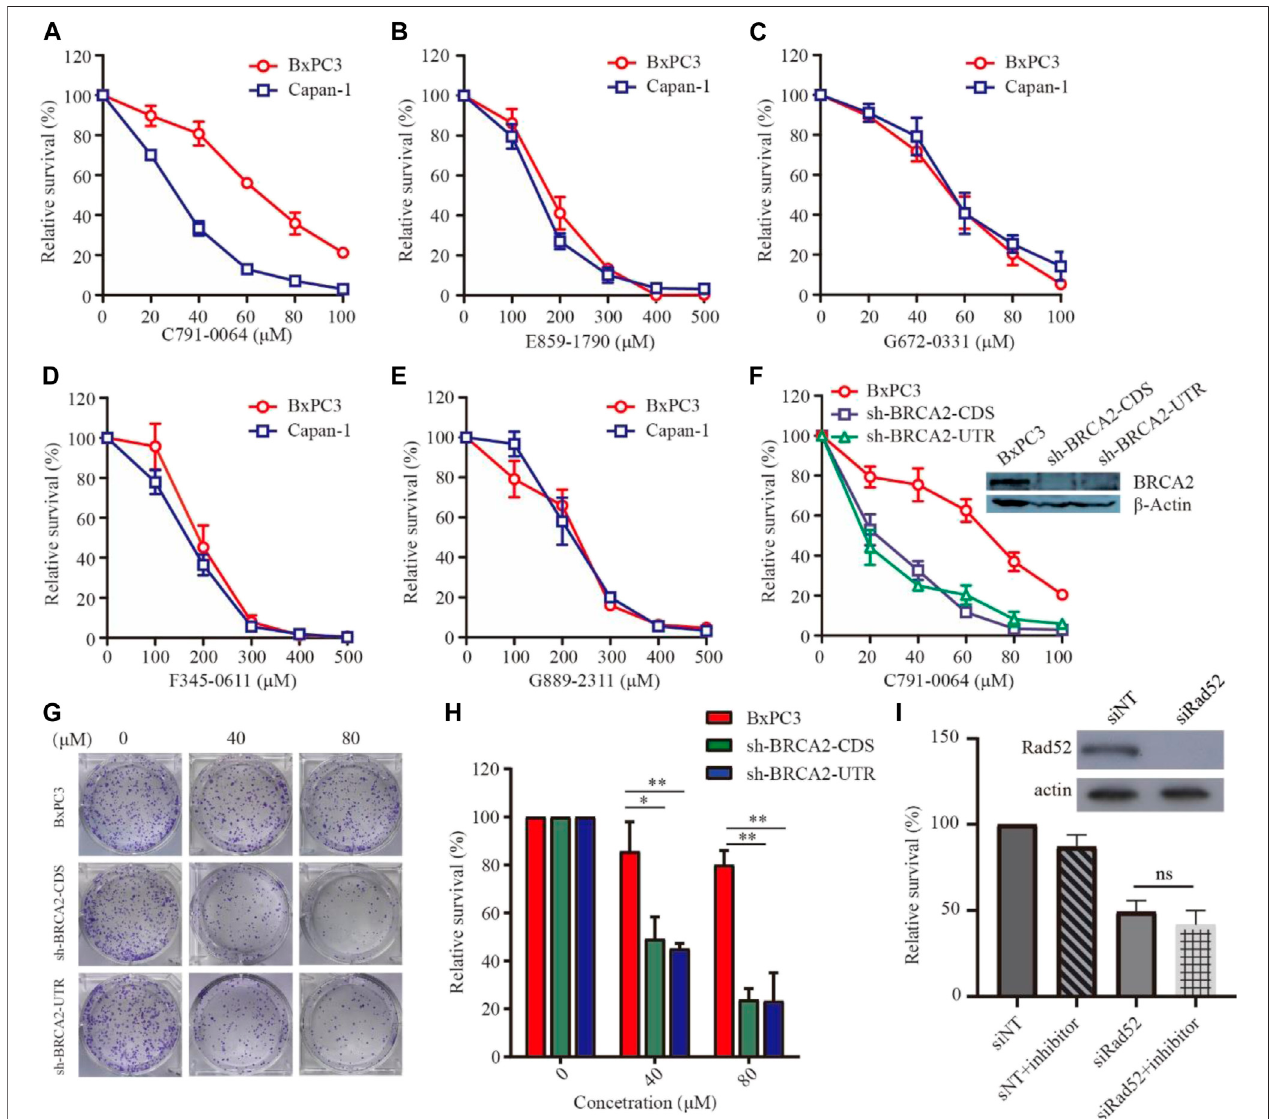
FIGURE3| EffectoftheputativeRAD52inhibitorsonthesurvivalofBRCA2wild-typeandde fi cientcells.Capan-1(BRCA2-de fi cient)andBxPC3(BRCA2wildtype) cellsweretreatedwithdifferentconcentrationsofthe fi vecompoundsfor72 h, (A) C791-0064, (B) E859-1790, (C) G672-0331, (D) F345-0611,and (E) G889-2311 (F) ( n (cid:2) 3). C791-0064 treatment of BRCA2-knockdown BxPC3 cells (sh-BRCA2-CDS and sh-BRCA2-UTR) and wild-type BxPC3 cells for 72 h ( n (cid:2) 3). CCK8 assay was performed to evaluate the cell survival. (G,H) Clonogenic assay performed with BRCA2 wild-type or BRCA2-knockdown cells and its quanti fi cation ( n (cid:2) 3). Error bars represent SDs. (I) siRNA knockdown of RAD52 in sh-BRCA2-CDS cells and treatment with C791-0064.